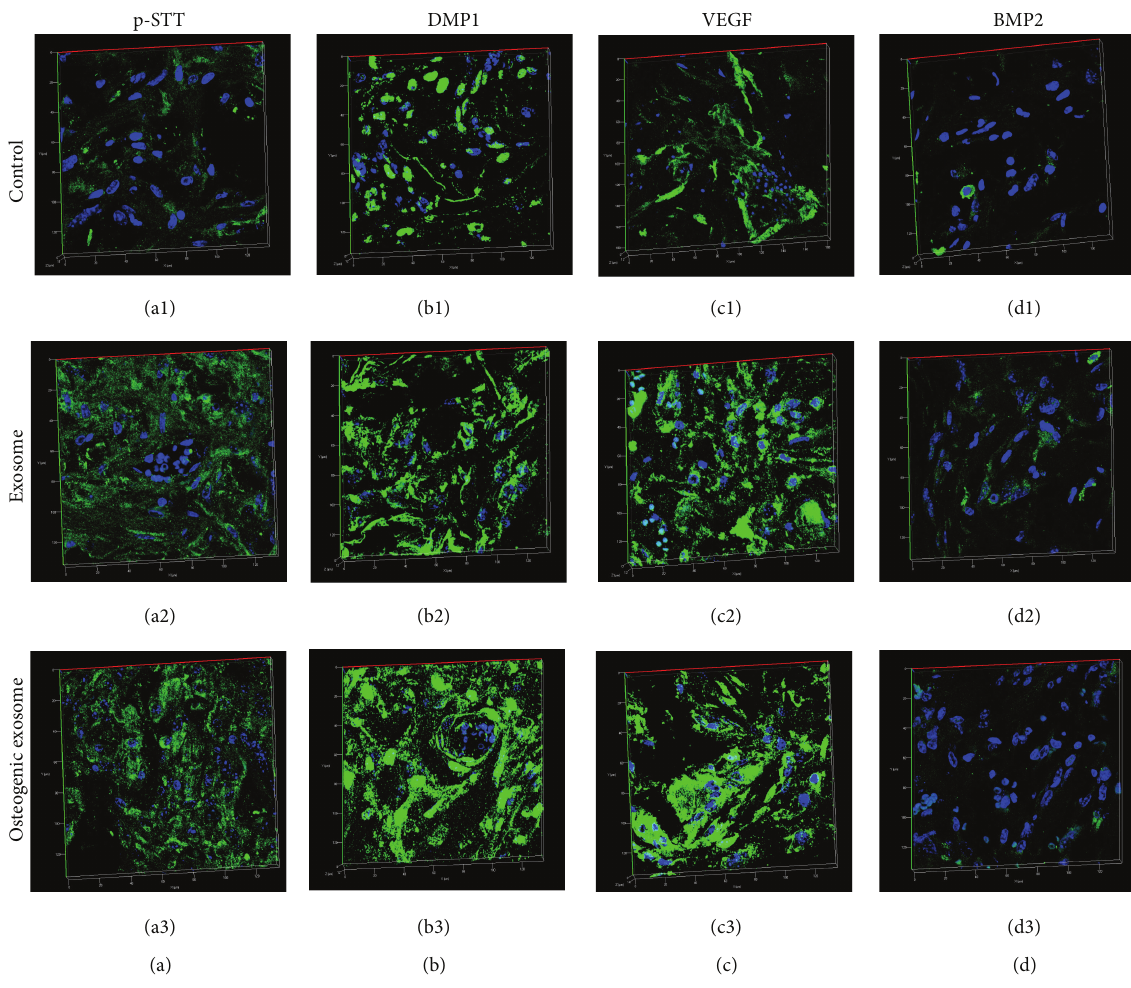
Figure 5: IHC of scaffold explant sections from in vivo implantation: all images are representative 3D reconstructions of z-stack confocal image slices. (a1, a2, and a3) represent sections from control, regular exosome, and osteogenic exosome treated samples, respectively, stained with pSTT antibody. (b1, b2, and b3) represent sections from control, regular exosome, and osteogenic exosome treated samples, respectively, stained with DMP1 antibody. (c1, c2, and c3) represent sections from control, regular exosome, and osteogenic exosome treated samples, respectively, stained with VEGF antibody. (d1, d2, and d3) represent sections from control, regular exosome, and osteogenic exosome treated samples, respectively, stained with BMP2 antibody. Except for BMP2, note the increase in the expression levels of proteins in the exosome treated